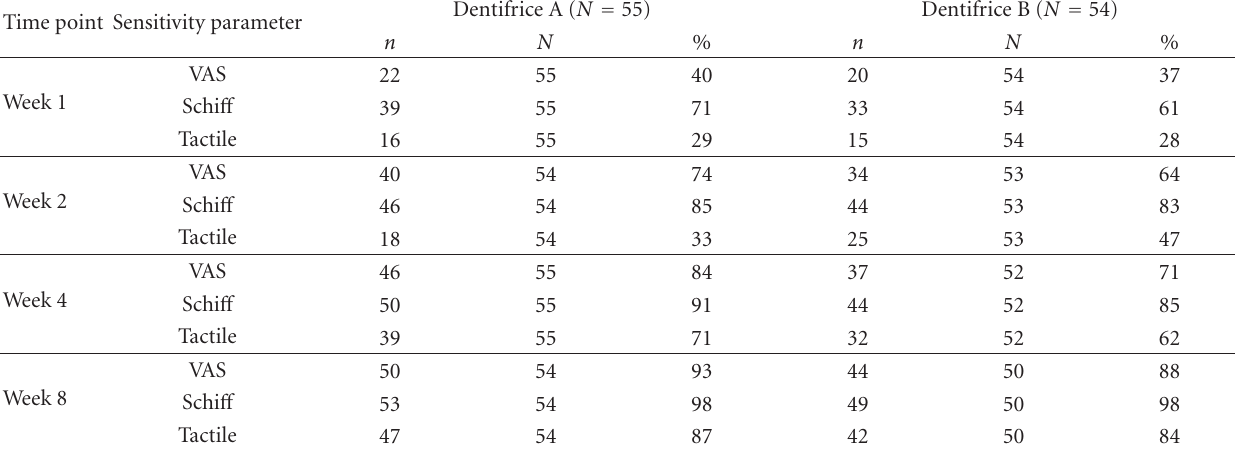
Table 3: Number of subjects with reduction in sensitivity (ITT population); Dentifrice A = Sensodyne Multi Action Iso-Active, Dentifrice B = Colgate Sensitive Pro-Relief. Reduction in sensitivity defined as Schi ff score decrease of at least 0.5 units; VAS score decrease of at least 10mm; tactile pain threshold increase of at least 10g. Percentages calculated from all subjects providing eligible data. Time point Sensitivity